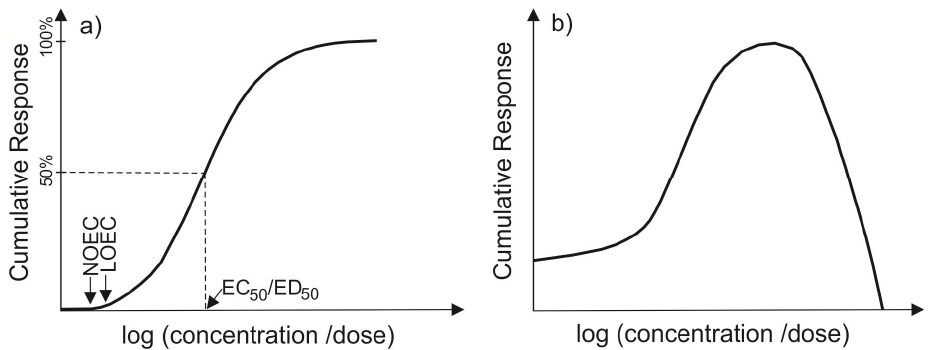
Figure 1. Different types of response to toxicant exposure: ( a ) classical dose-response (greater effect with increasing dose) and ( b ) example of a nonmonotonic response (greater effect with decreasing dose after peak, referring to sublethal